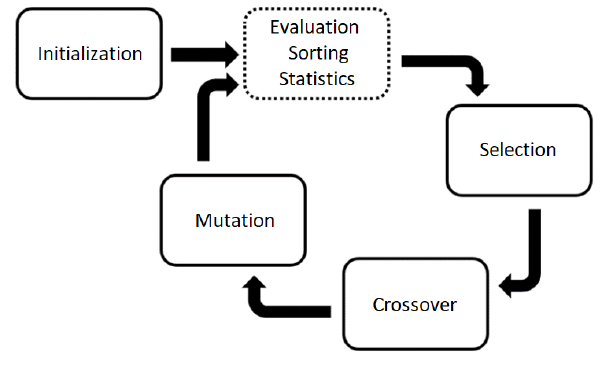
Figure 2. Genetic algorithm.